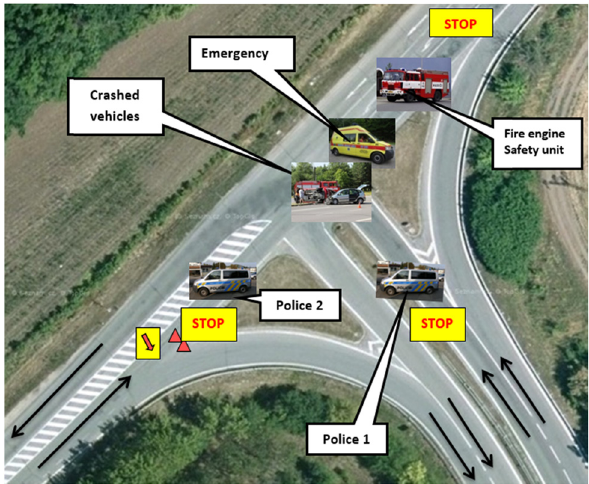
Figure 4: Possible arrangement of the Integrated Rescue System vehicles during the tra ffi c